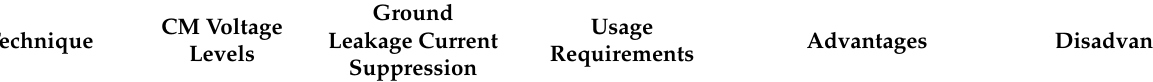
Table 3. Main features of compared reduction methods of common-mode voltage impact in electric